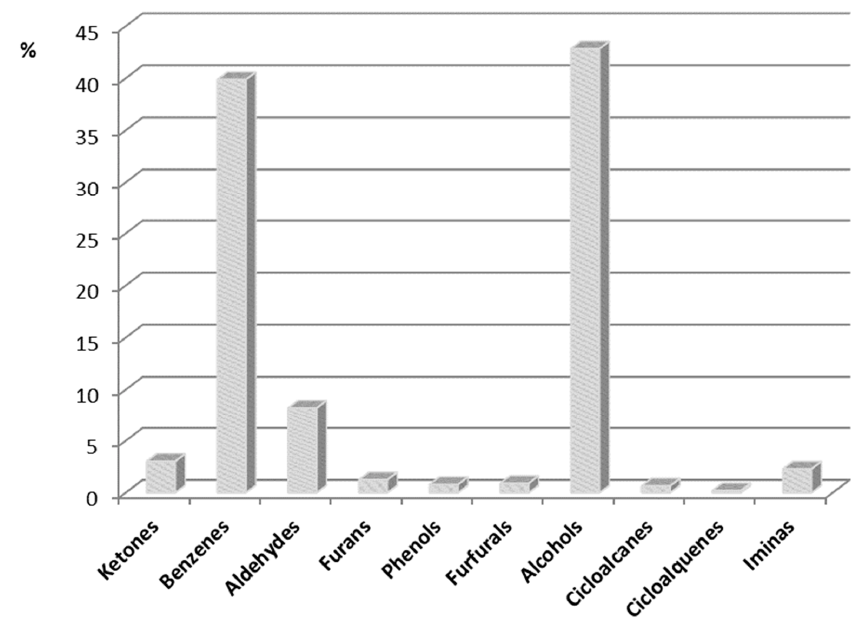
Figure 4. Volatile compounds obtained in the liquid effluent from the SCWG of cellulose at 560 °C.